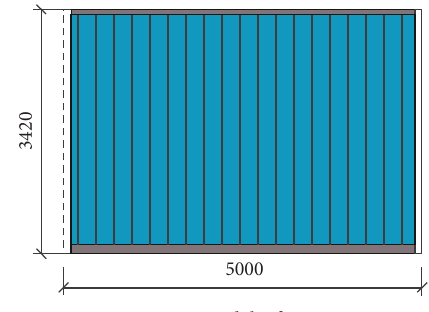
Figure 7: Model of QY-2.